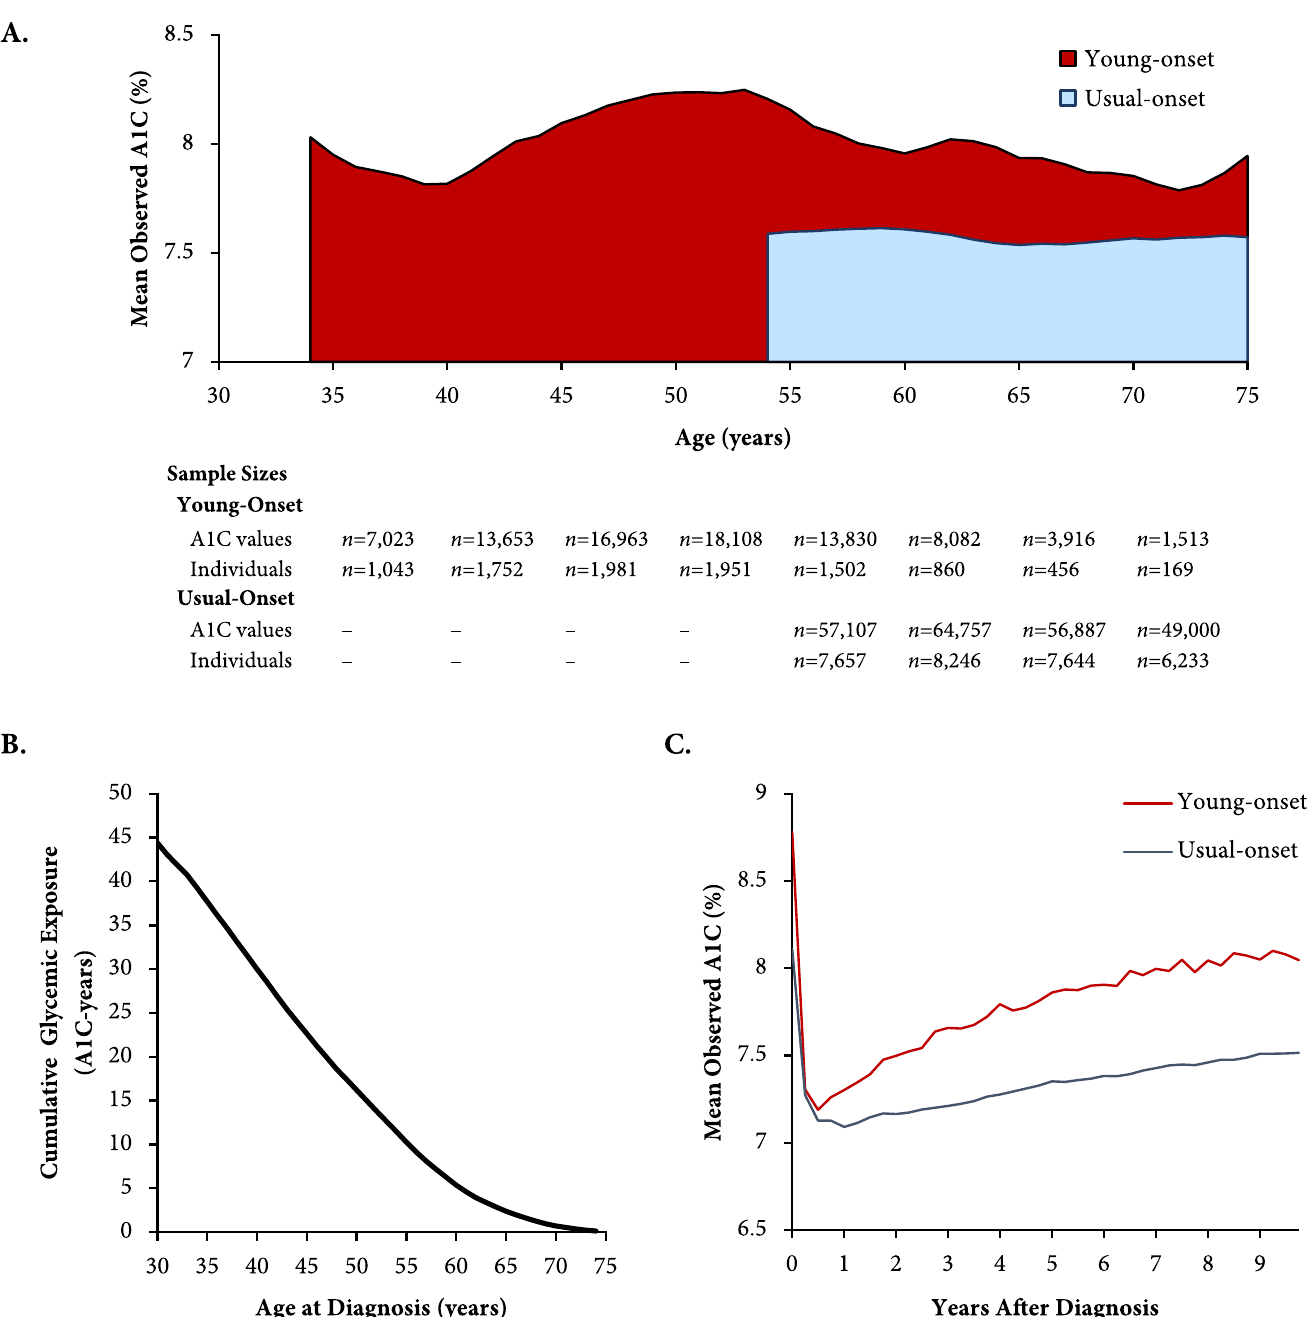
Fig 1. Observed A1C and glycemic exposure among adults in the register and population cohorts. These A1C values are not adjusted for medications. (A) Mean observed A1C across the age span (attained age) in the register cohort (2000–2016), stratified by age at diagnosis (smoothed using 3-year moving averages). The shaded areas indicate glycemic exposure in excess of 7%. Sample sizes are indicated for each 5-year age group. (B) Cumulative glycemic exposure in the register cohort (2000–2016), defined as area under the A1C curve in excess of 7%, by age at diagnosis. One A1C-year is equivalent to one year of exposure to an average A1C of 8%. For example, a person diagnosed with diabetes at age 30 years, with an average A1C of 8% from age 30 to 75 years, would have been exposed to a 1% excess in A1C over 45 years, which is equivalent to 45 A1C-years of glycemic exposure. (C) Mean observed A1C by years since type 2 diabetes diagnosis in the population cohort (2002–2016), stratified by age at diagnosis. A1C, hemoglobin A 1c .